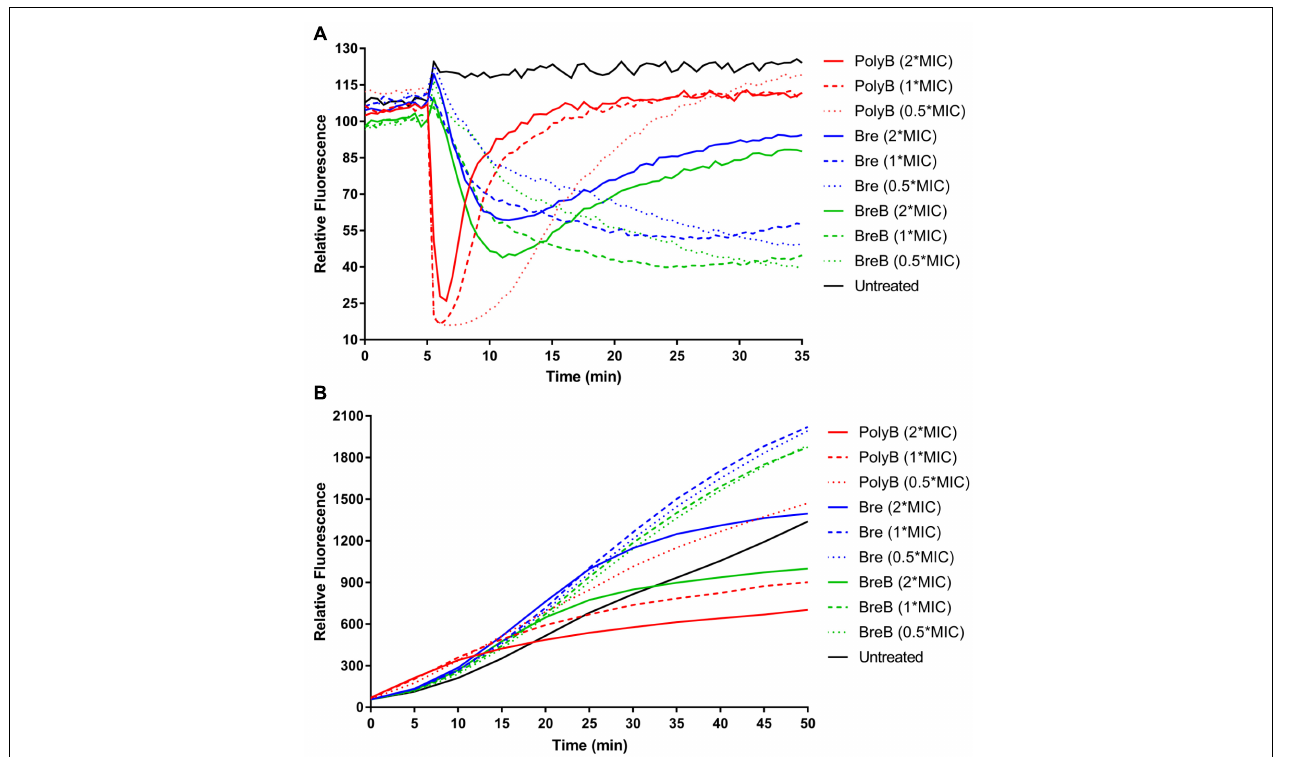
FIGURE 4 | Brevicidines disrupt the proton motive force of Gram-negative bacteria. (A) DiSC 3 (5) fluorescence in E. coli upon exposure to polymyxin B [4 mg/L (2 × MIC), 2 mg/L (1 × MIC) or 1 mg/L (0.5 × MIC)], Bre [4 mg/L (2 × MIC), 2 mg/L (1 × MIC) or 1 mg/L (0.5 × MIC)], and BreB [4 mg/L (2 × MIC), 2 mg/L (1 × MIC) or 1 mg/L (0.5 × MIC)]. Representative examples from three technical replicates are shown. (B) Resorufin fluorescence in E. coli upon exposure to polymyxin B [4 mg/L (2 × MIC), 2 mg/L (1 × MIC) or 1 mg/L (0.5 × MIC)], Bre [4 mg/L (2 × MIC), 2 mg/L (1 × MIC) or 1 mg/L (0.5 × MIC)], and BreB [4 mg/L (2 × MIC), 2 mg/L (1 × MIC) or 1 mg/L (0.5 × MIC)]. Representative examples from three technical replicates are